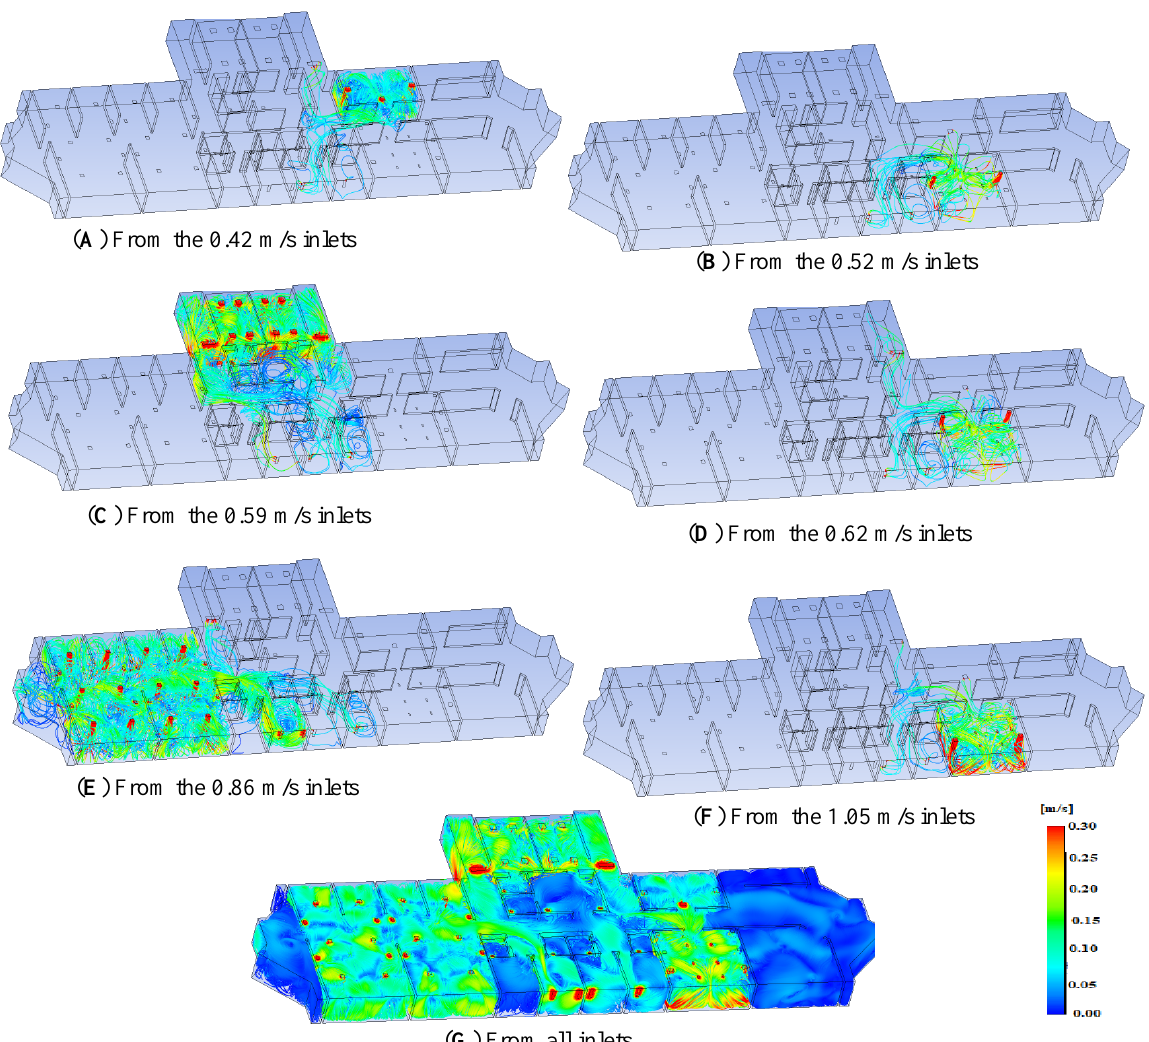
Figure 8. Velocity streamlines from all inlets.